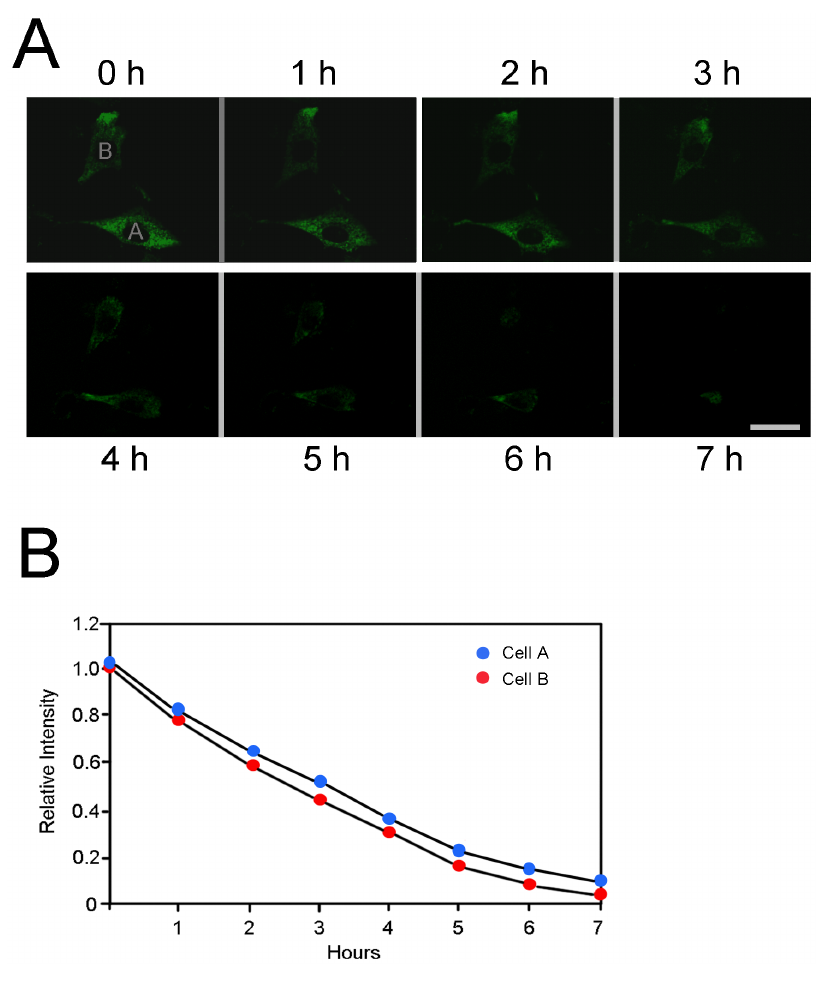
Figure 4. Photoactivation of myocilin WT -PAGFP. A . Human TM cells transfected with expression vector myocilin WT -PAGFP were imaged using 488-nm excitation. Selected cells were irradiated by 405-nm light. Green fluorescence, representing myocilin-GFP, was seen distributed in the entire cell upon irradiation. The field was monitored for 24 h and the fluorescence intensity at various time points was qualified by Image J. Images of two representative cells (cell A and cell B that displayed low intensity of green fluorescence) at time points 0, 1, 2, 3, 4, 5, 6, and 7 h are shown. B . The fluorescence intensity of myocilin WT -GFP in cells A and B was plotted against time to estimate the myocilin WT -GFP half-life.